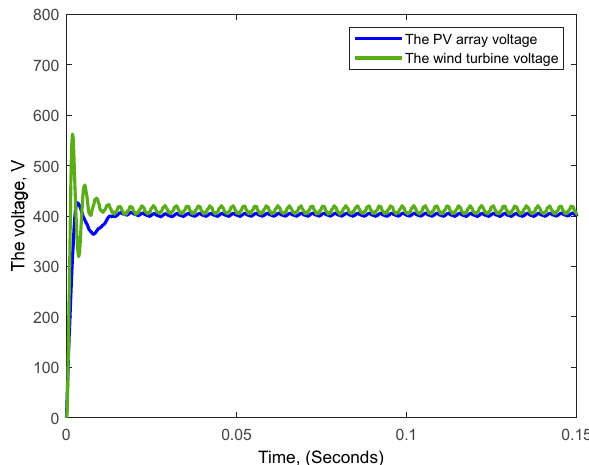
Figure 6. The DC input voltage of the inverters.